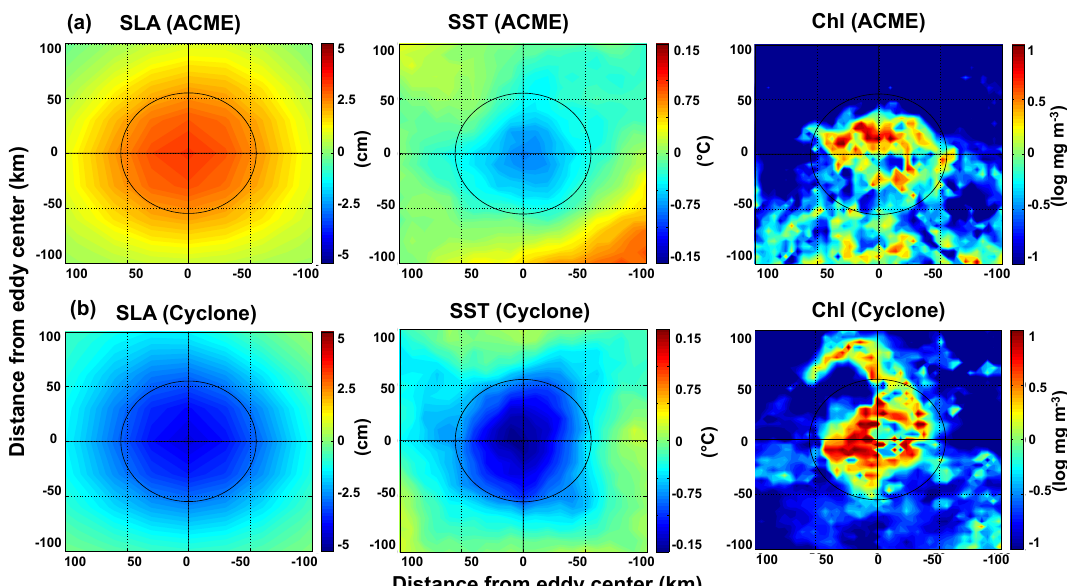
Figure 6. Composites of surface signature for SLA, SST and Chl from all detected low-oxygen eddies: (a) ACMEs and (b) CEs. The solid black cross marks the eddy center and the solid black circle the average radius. Due to significant cloud cover the number of Chl data are much less when compared to the SLA and SST data; thus there is more lateral structure.